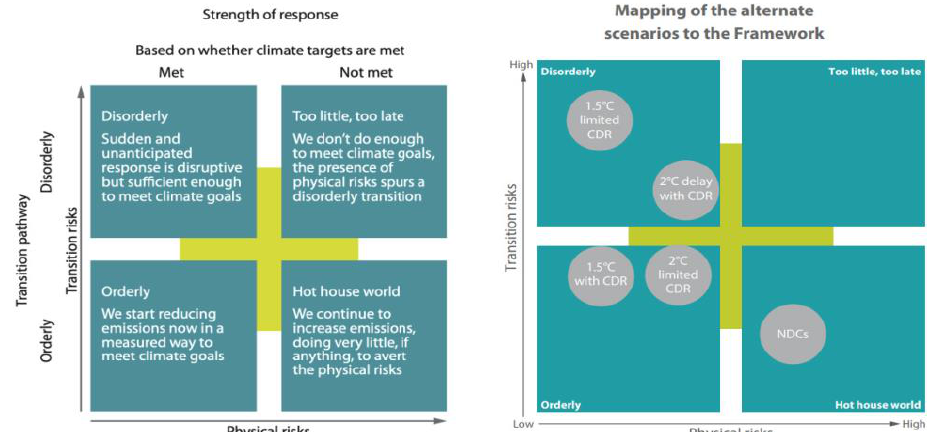
Figure 3: Integration of Physical and Transition Scenarios Based on NGFS Climate Scenarios